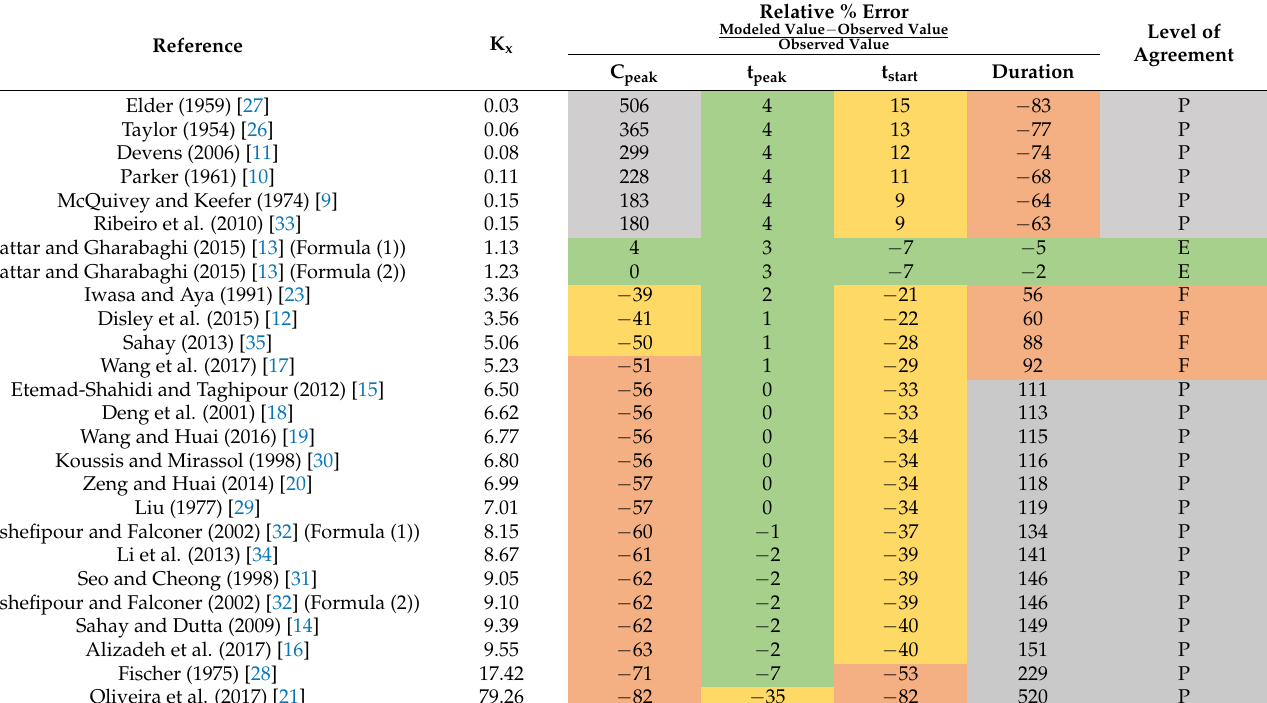
Table 5. Relative error according to predictive formulas in the concrete channel.